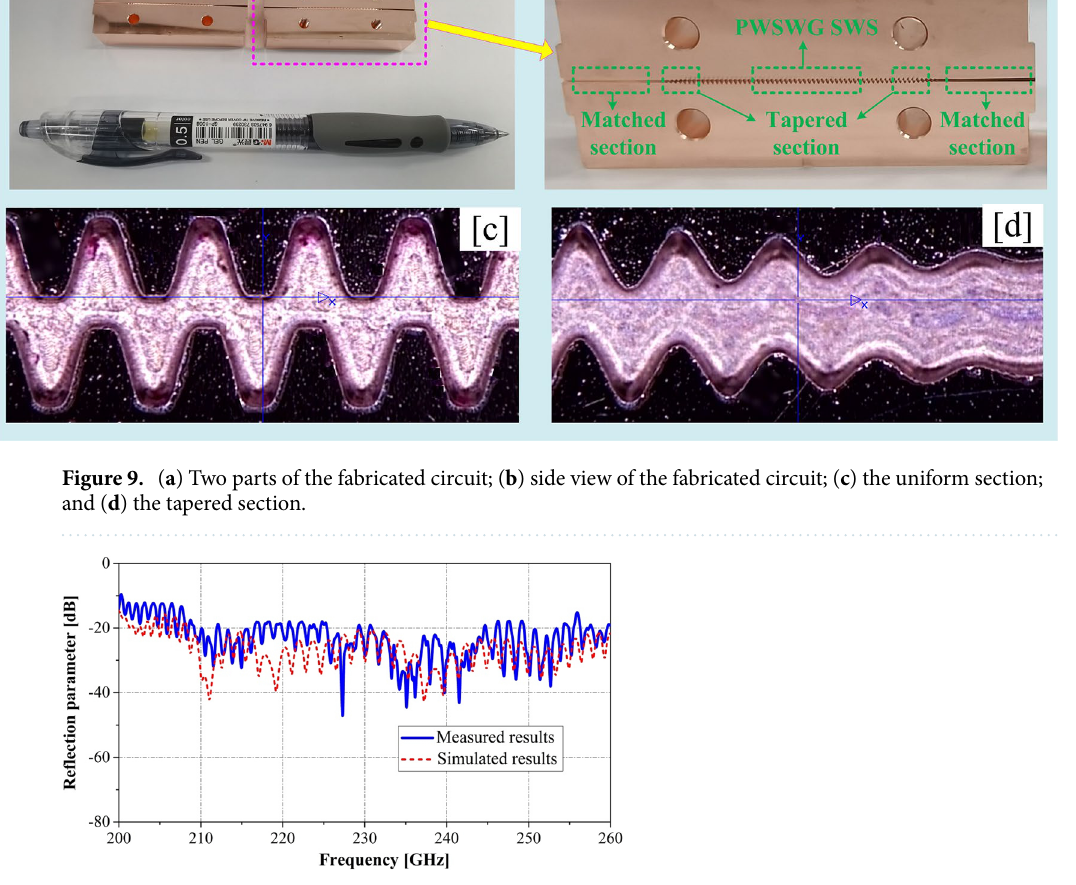
Figure 10. Comparison between measured results and simulated results of reflection